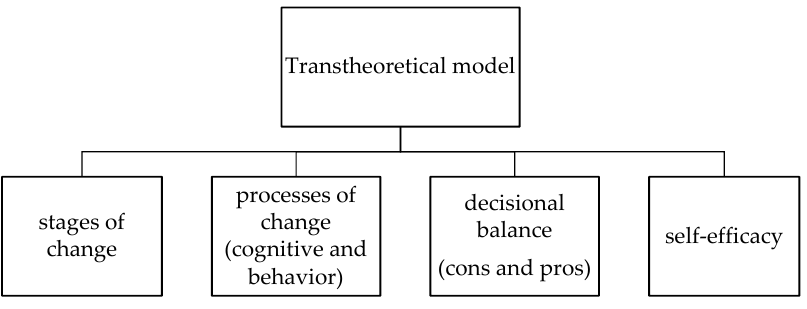
Figure 1. The four core constructs of TTM.